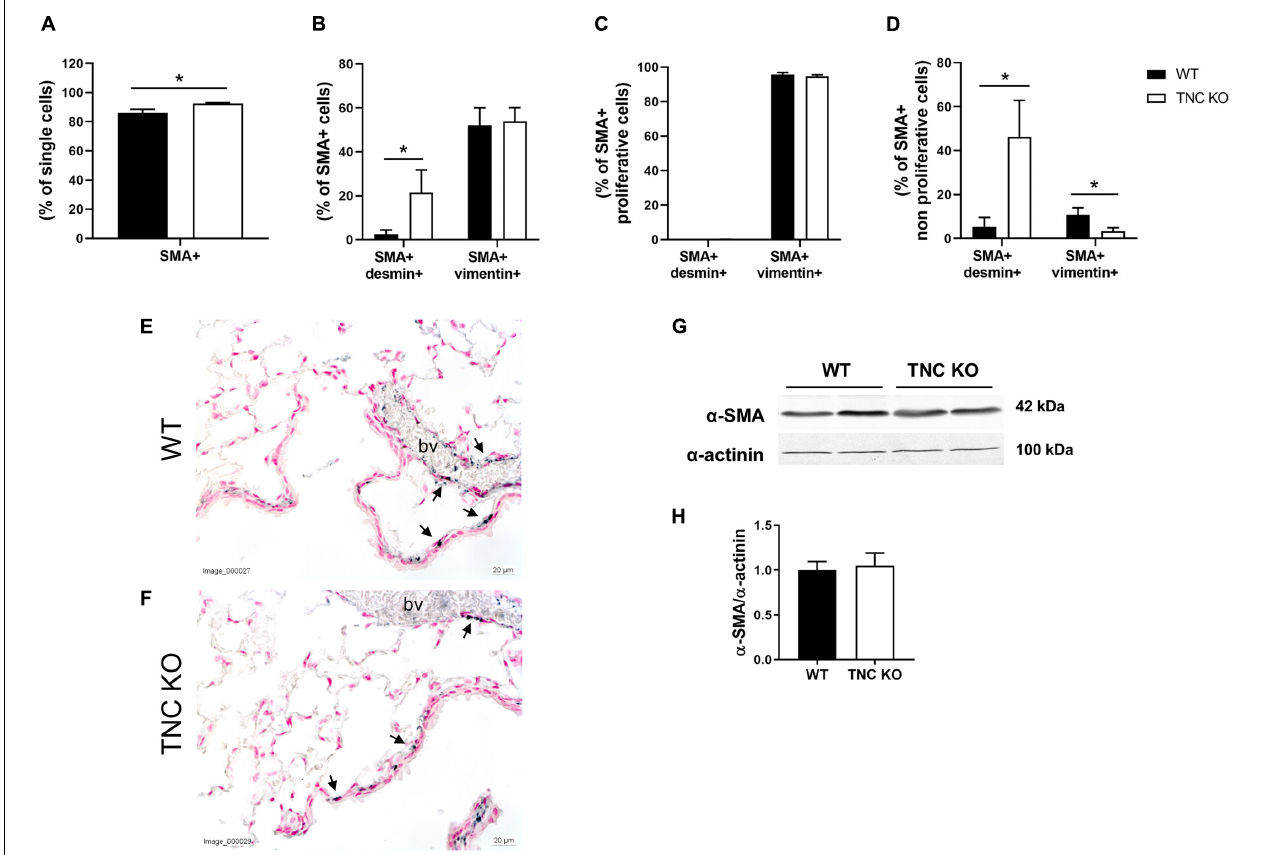
FIGURE 7 | α -SMA positive cells in old TNC-deficient and WT lungs. (A–D) : flow cytometry quantification of α -SMA, desmin and vimentin in old female TNC KO and WT lung samples; proliferation status was evaluated using an EdU assay kit. N = 3 animals/genotype. Statistical analyses were made by Student’s t test; statistical significance was set at p < 0.05; * p < 0.05. (E,F) : representative images of lung sections from TNC KO and WT old animals immunostained with anti- α -SMA antibody (dark gray; black arrows) and counter-stained with Nuclear Red. N = 3–5 animals/genotype. bv: blood vessel. (G,H) : representative results of α -SMA protein detection in whole lung lysates from old TNC-deficient and WT animals by Western blot; quantification is shown in histogram; N = 6–7 animals/genotype. Cropped blots are